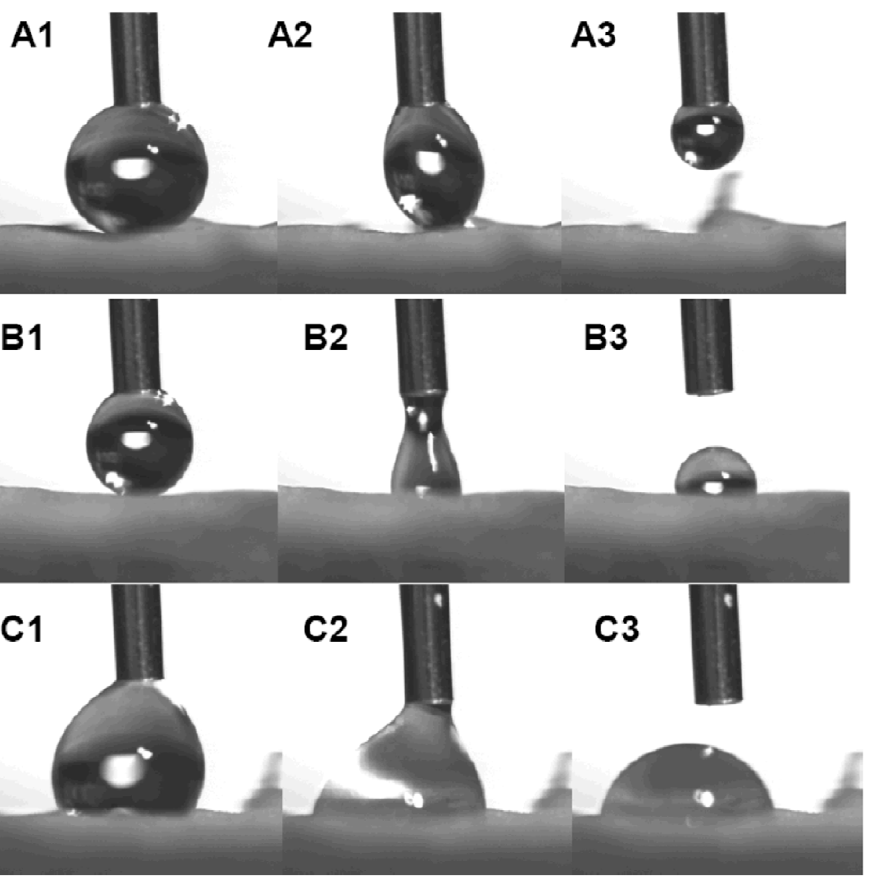
Figure 3. Measurement of floral surface wettability. A1 . Advancing angle of drop on surface showing Cassie-Baxter wetting. A2 . Receding angle of drop showing Cassie-Baxter wetting. A3 . Ease of drop removal on a surface showing Cassie-Baxter wetting. B1 . Advancing angle of drop on surface showing Partial Cassie-Baxter wetting. B2 . Receding angle of drop showing Partial Cassie-Baxter wetting. B3 . Drop removal on a surface showing Partial Cassie-Baxter wetting, showing that while initial removal is similar to perfect Cassie-Baxter wetting, a localized point remains. C1 . Advancing angle of drop on surface showing Wenzel wetting. C2 . Receding angle of drop showing Wenzel wetting. C3 . Attempted drop removal on a surface showing Wenzel wetting.